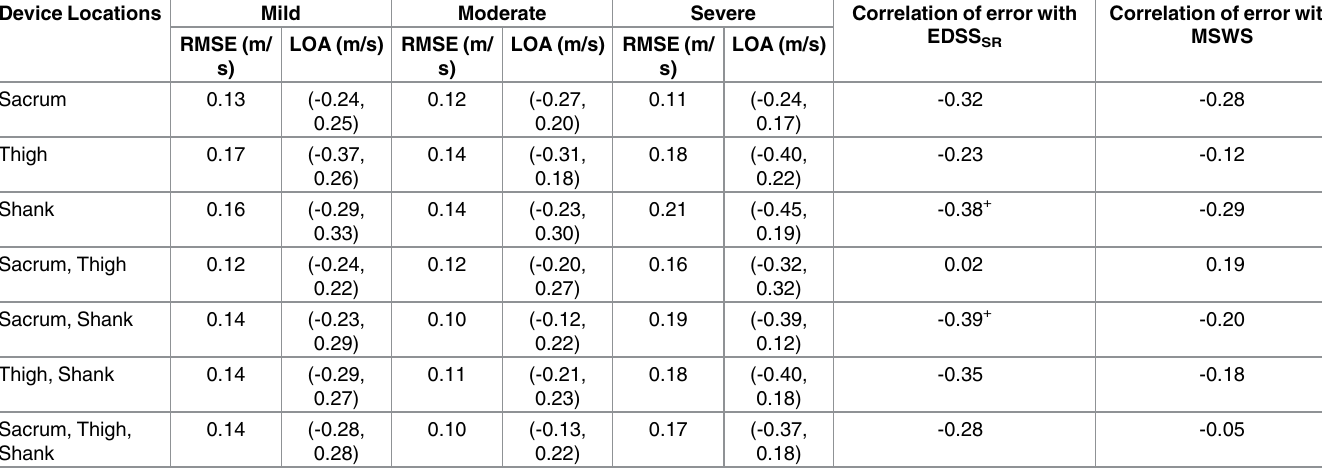
Error metrics include RMSE and LOA. Statistical significance at the α = 0.05 level indicated with + .